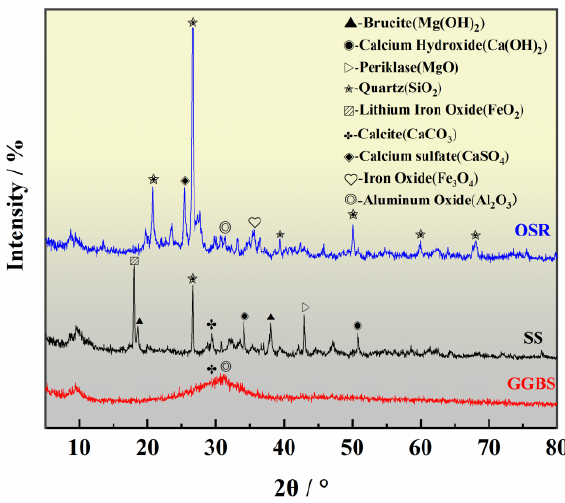
Figure 3. XRD patterns of the OSR, SS and GGBS.